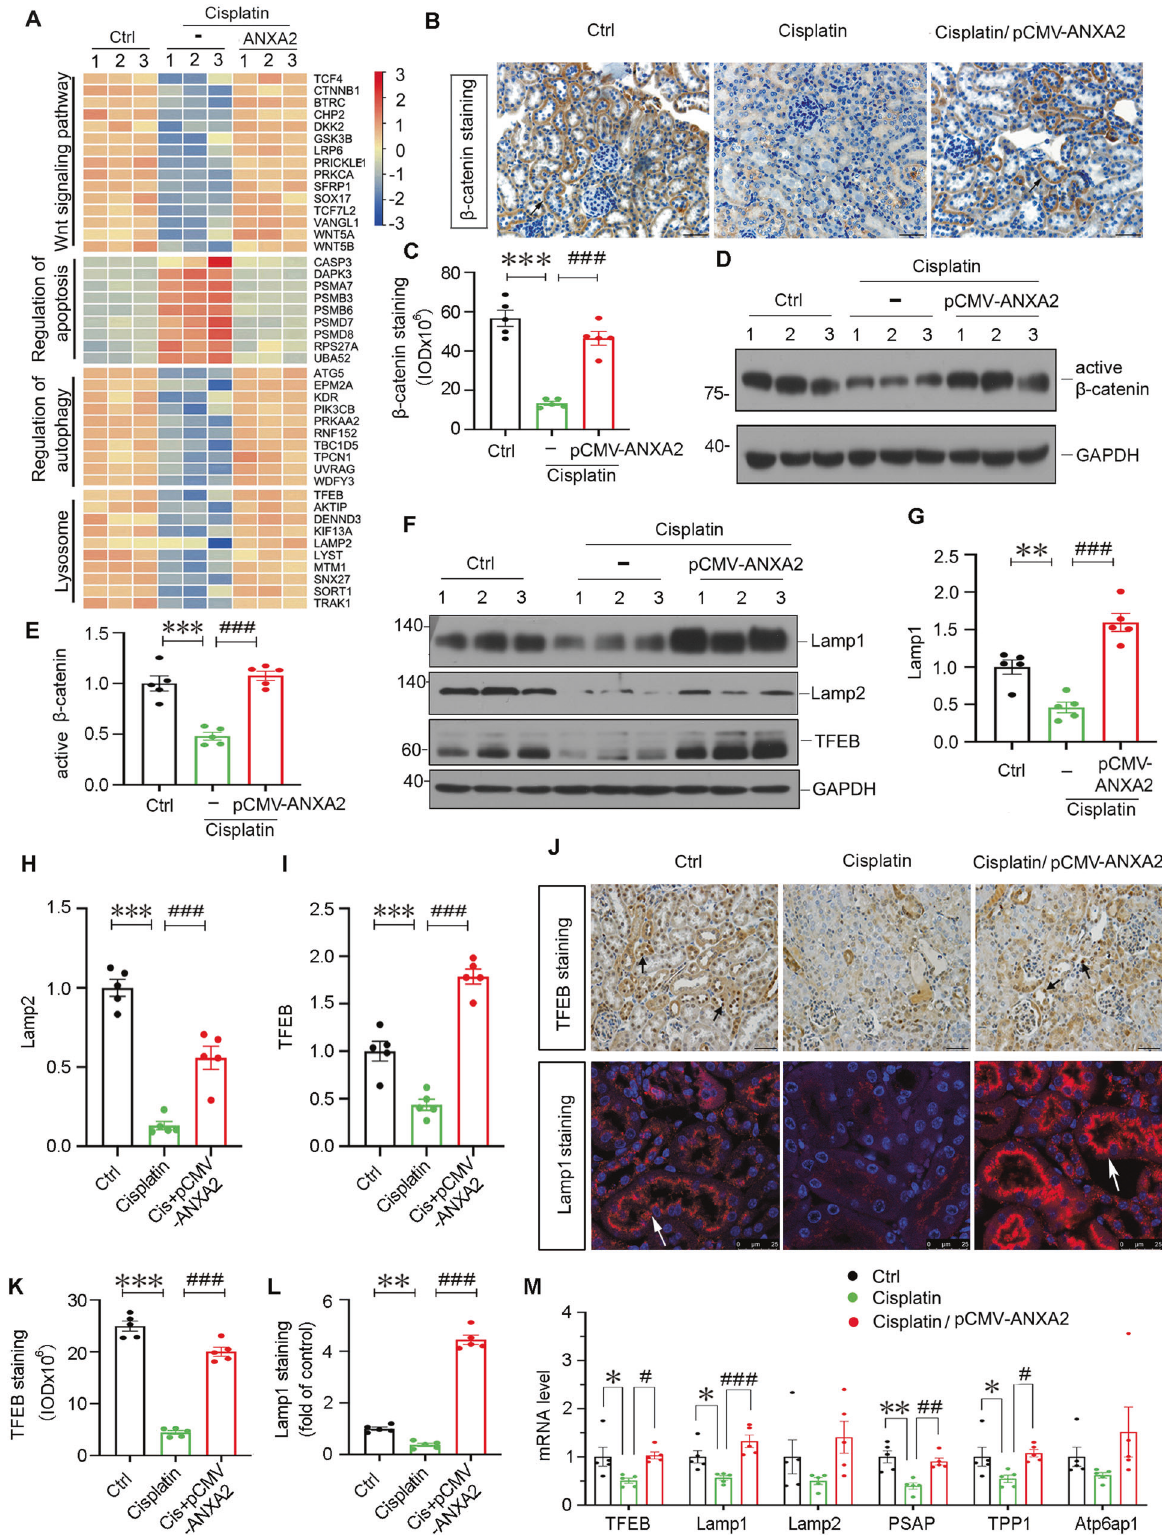
ANXA2 protects against AKI We then examined whether ANXA2 protects against cisplatin- induced AKI. The experimental design was shown in Fig. 2A. ANXA2 was overexpressed by injection of an expression plasmid Cell Death Discovery (2022)